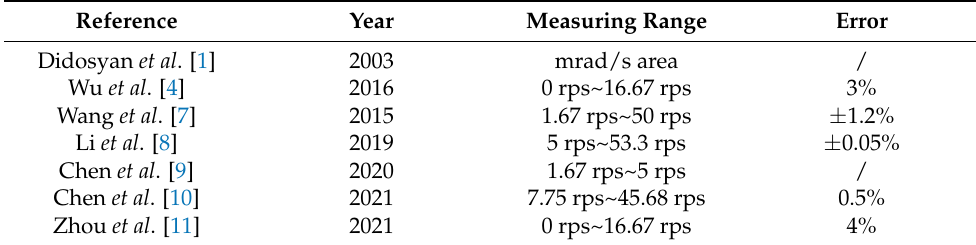
Table 1. Current rotational speed sensors.